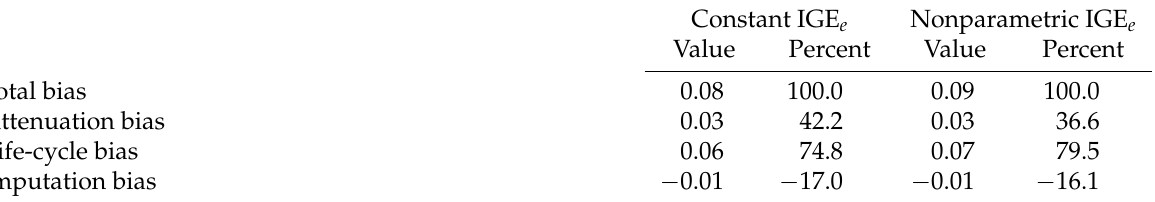
Table 4: Model-specific Shapley decompositions of total bias in IGE e